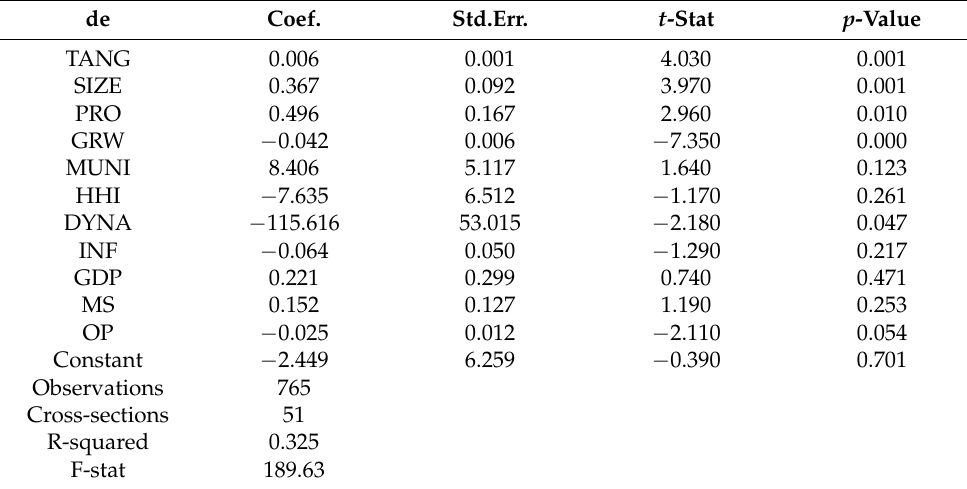
Table A5. Regression with Driscoll–Kraay Standard